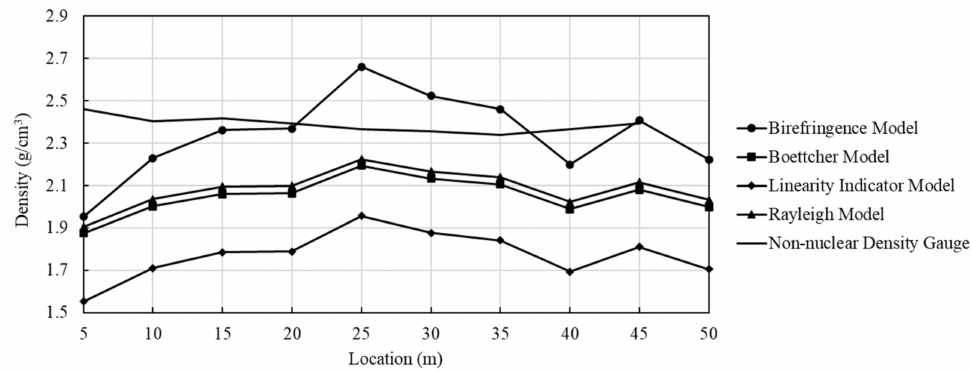
Figure 9. Comparison of the predicted density by the four prediction models and the measured density by the non-nuclear density gauge.